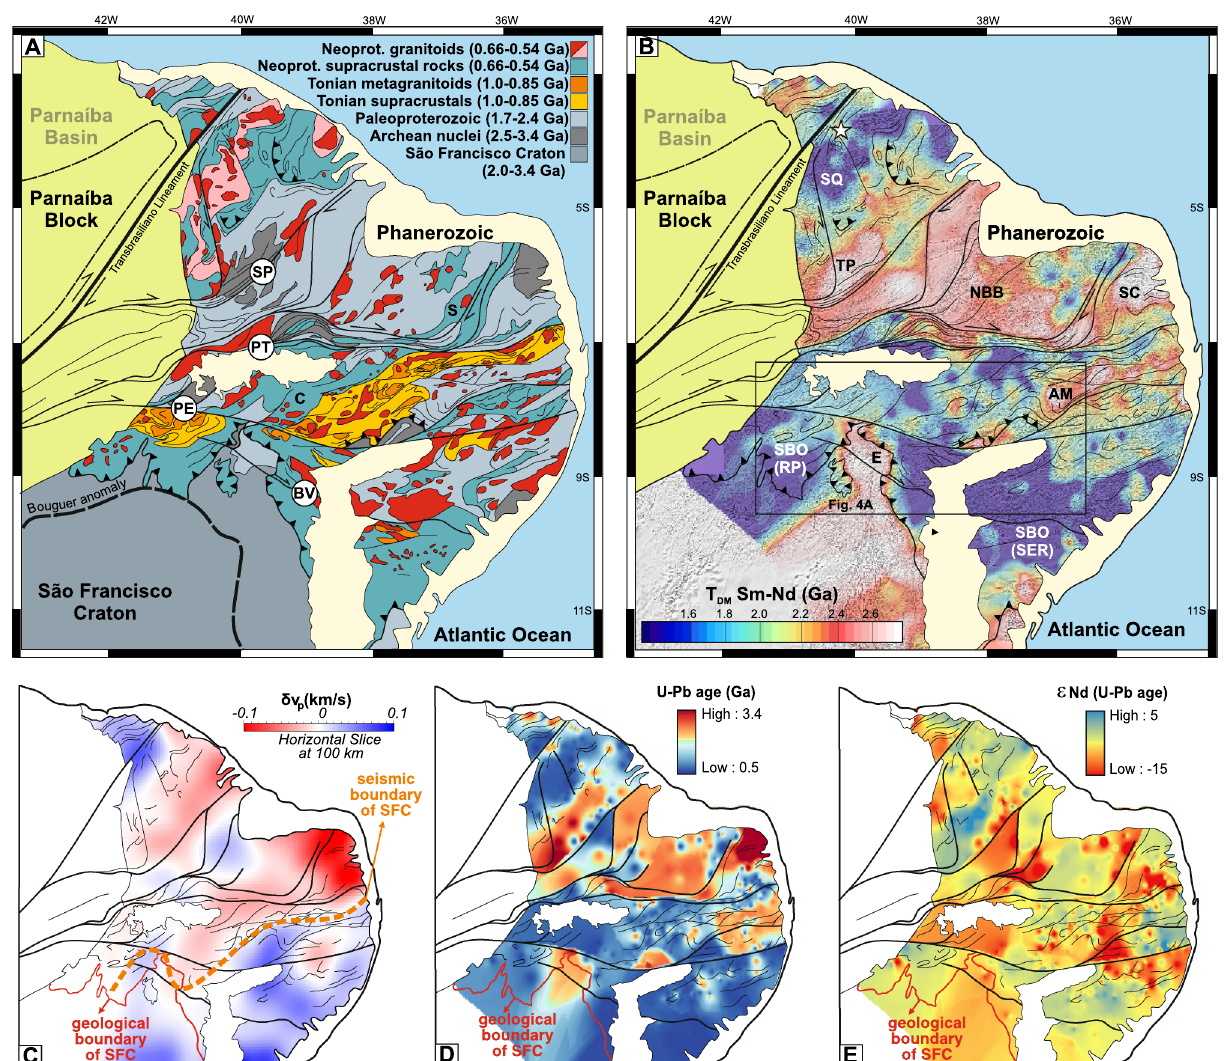
Figure 1. Age of lithological units and distribution of model ages in the Borborema Province. ( A ) Interpreted geological-age map of the Borborema Province. Labels correspond to names of shear zones. Geological base maps are from the Geological Survey of Brazil and freely available at http://geosg b.cprm.gov.br. ( B ) Sm–Nd T DM age map of the Borborema Province and northern São Francisco Craton with magnetic first derivative image